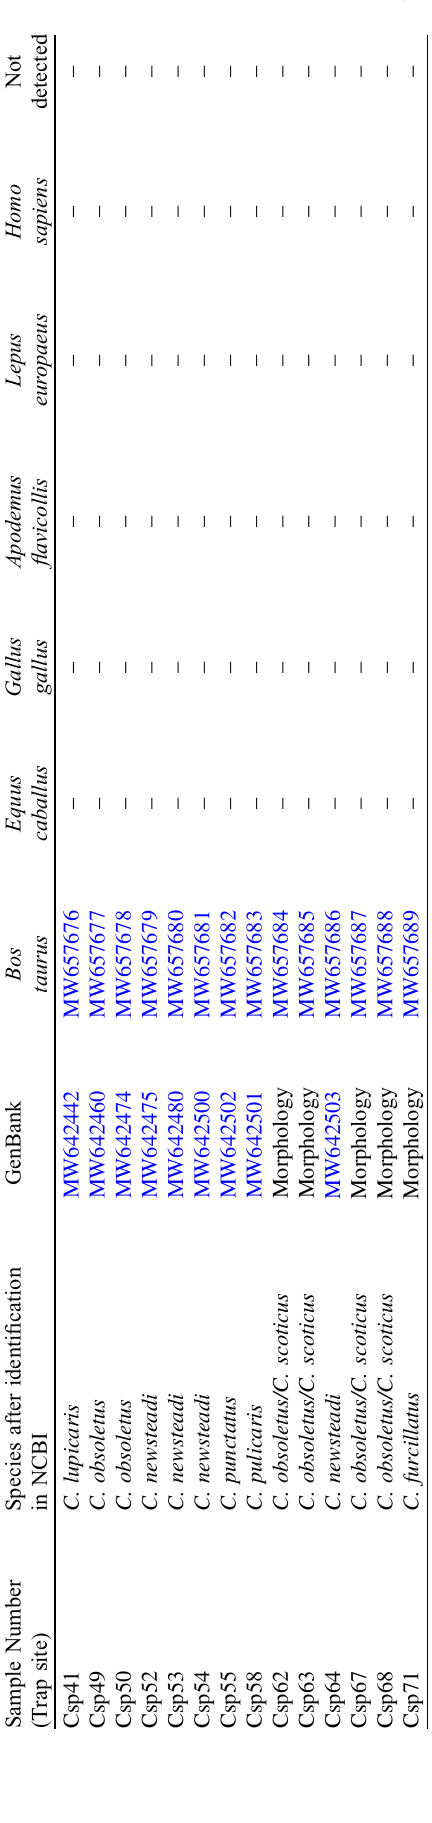
Blood-meal molecular analysis Molecular identi fi cation of the blood meals from individual blood-engorged females was performed by sequencing part of the cytochrome b (cyt b) mitochondrial gene (350 bp). All PCRs were performed in a total volume of 47 l L, including 3 l L of total genomic DNA template, 21 l L of Emerald AmpGT PCR Master Mix (Takara, Shiga, Japan), 21 l L of nuclease-free water, and 1 l L of each primer (Sigma-Aldrich). The PCRs were performed on a Master cycler nexus X2 (Eppendorf, Germany) using universal vertebrate primers, for-